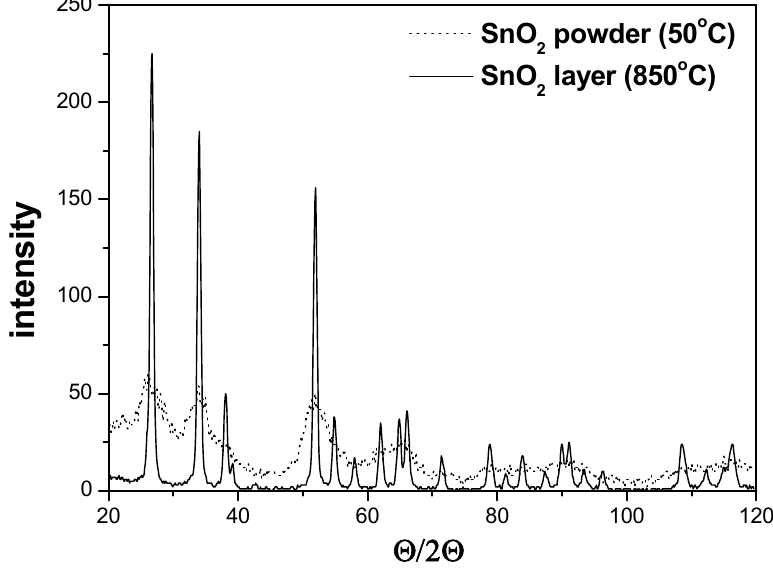
Figure 1. X-ray diffractogram of the powder and the thick film SnO